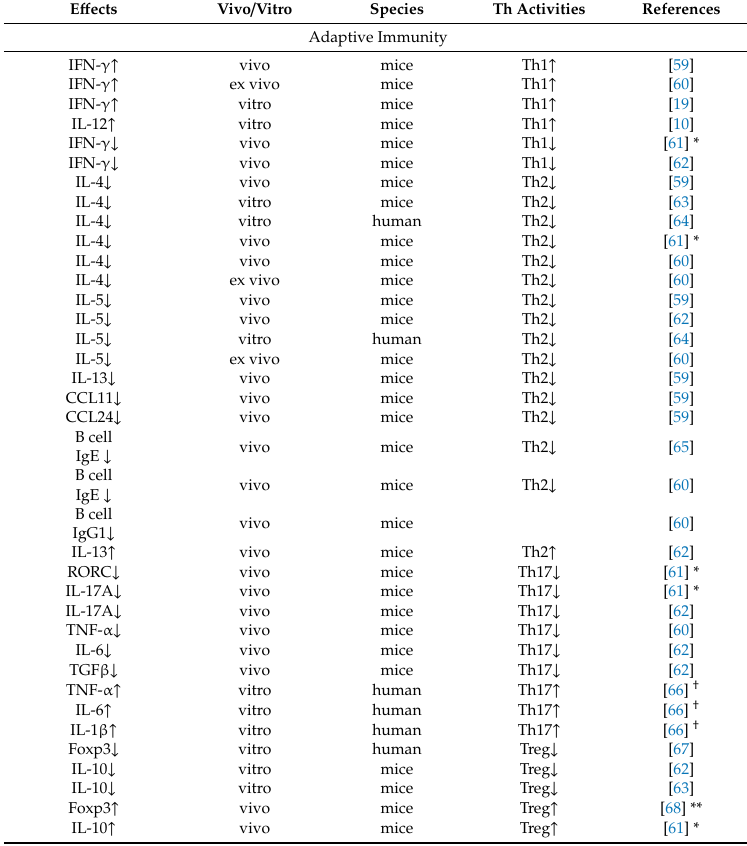
Table 5. Summary of the e ff ects of dehydroepiandrosterone (DHEA) on the activities of T helper 1 cell (Th1), Th2, Th17, and regulatory T cell